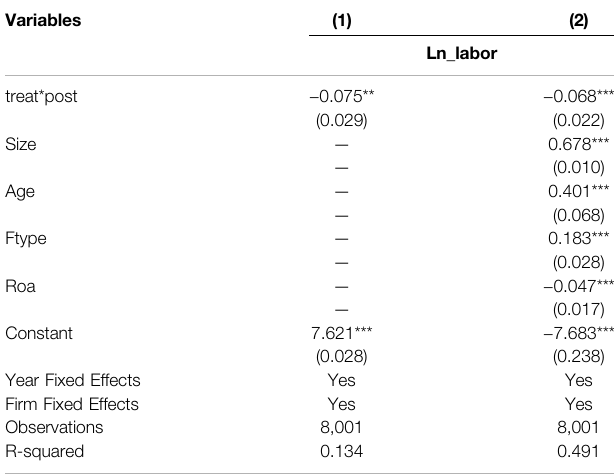
TABLE 2 | The impact of the ETP on fi rms ’ labor